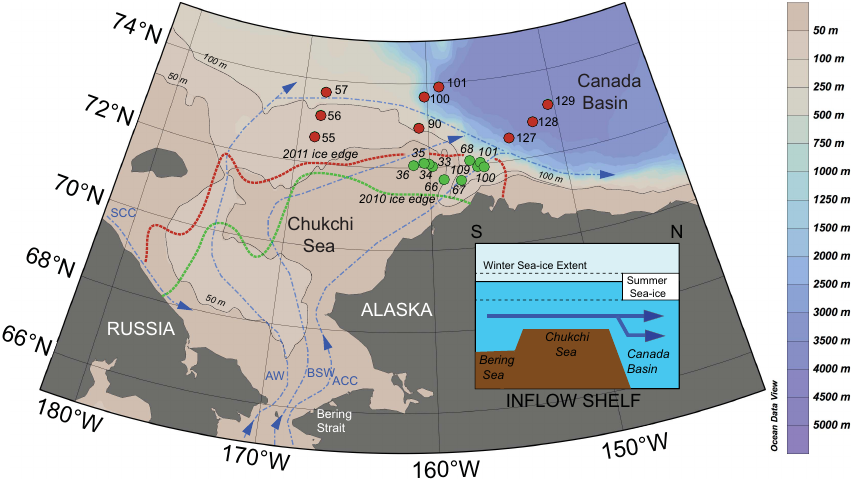
Figure 1. Map of the western Arctic Ocean showing the sea-ice stations occupied during the ICESCAPE cruises of 2010 (red symbols) and 2011 (green symbols) with sea-ice station numbers also shown. The approximate sea-ice edge is shown for 2010 (bold dashed green line) and 2011 (bold dashed red line). Approximate streamlines (blue dashed lines) of water flow across the Chukchi Sea are shown and include the following water masses: Alaskan Coastal Current (ACC), Bering Shelf Water (BSW) and Anadyr Water (AW). The intermittent flow of the Siberian Coastal Current (SCC) through Long Strait into the Chukchi Sea is also shown. Sea ice data were retrieved from the National Sea-Ice Data Center (Cavalieri et al., 1996, updated yearly; http://nsidc.org/data/seaice/index). INSET. A schematic of the “inflow” shelf is shown illustrating the northward flow of water across the shelf from the Bering Sea, through Bering Strait, and across the Chukchi Sea shelf to the Canada